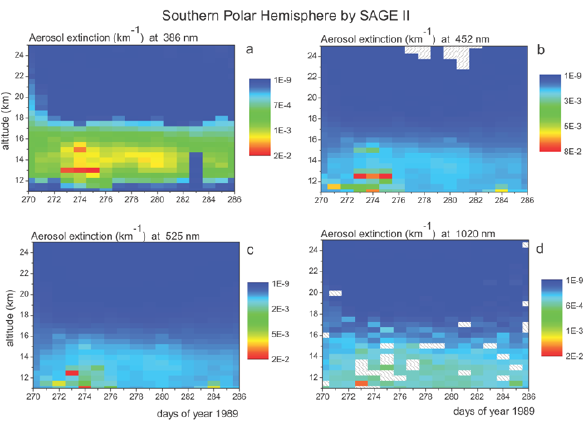
Fig. 3. SAGE II aerosol optical properties such as aerosol extinc- tions at four wavelengths 1020nm, 525nm, 453nm and 386nm for the polar Southern Hemisphere.